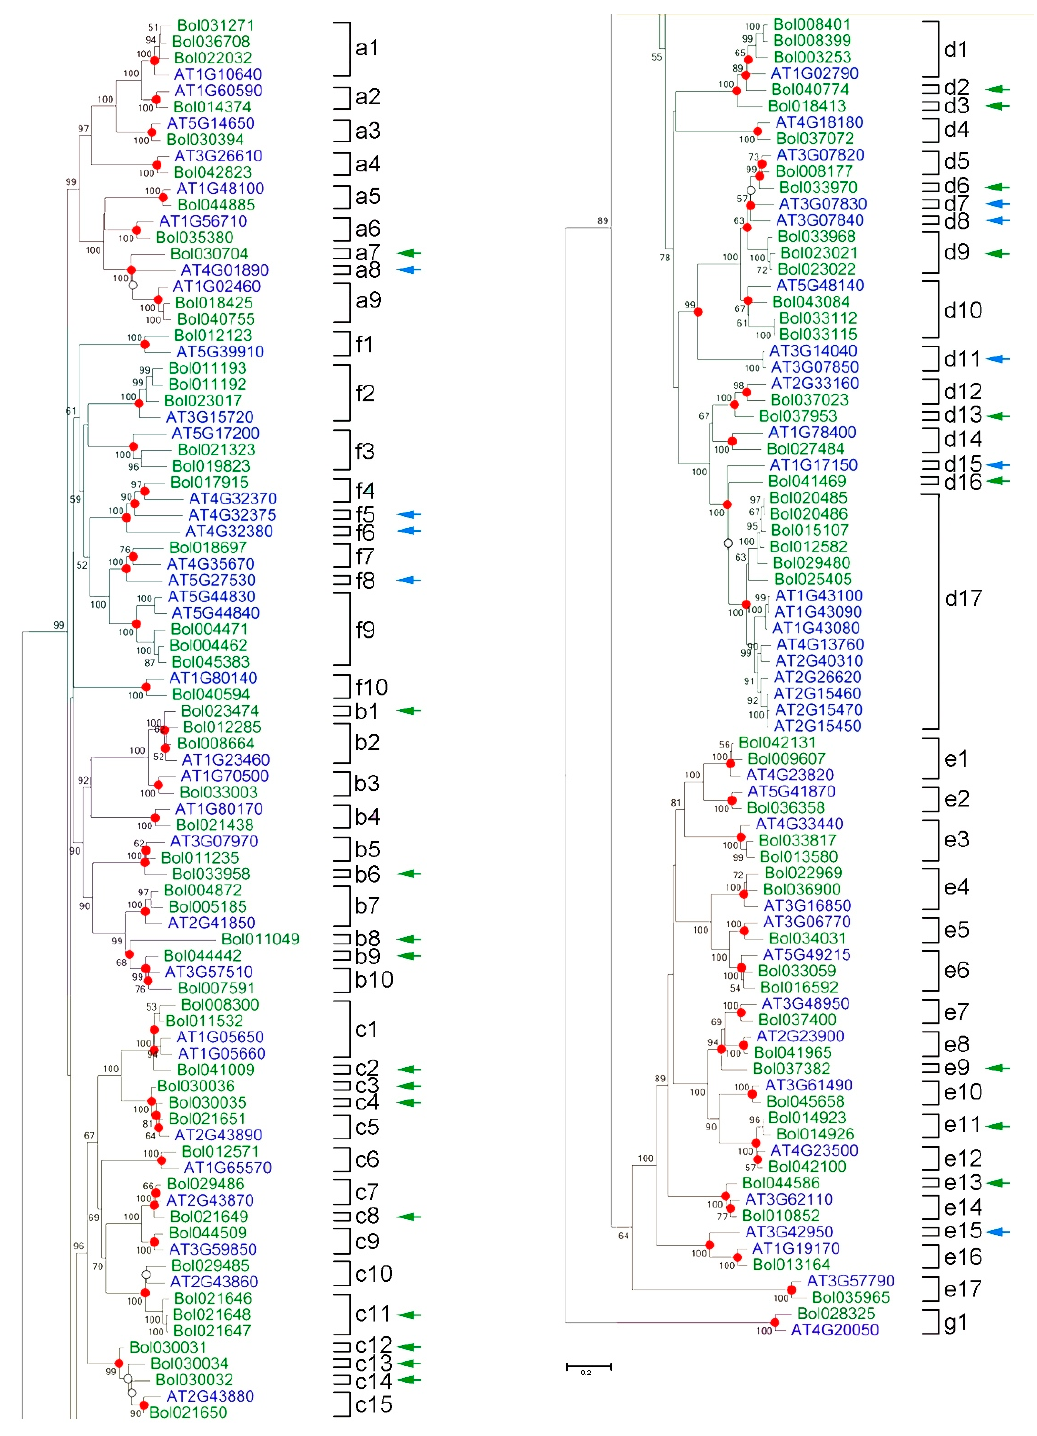
Figure 4. Phylogenetic tree of B. oleracea and Arabidopsis thaliana PGs. Numbers on branches indicate the bootstrap percentage values calculated from 1000 replicates, and only values higher than 50% are shown. The nodes that represent the most recent common ancestral genes before the B. oleracea and A. thaliana split are indicated by red dots (bootstrap support > 50%) and white dots (bootstrap support < 50%). Clades that contain only B. oleracea and A. thaliana PG genes are indicated by green and blue arrows,